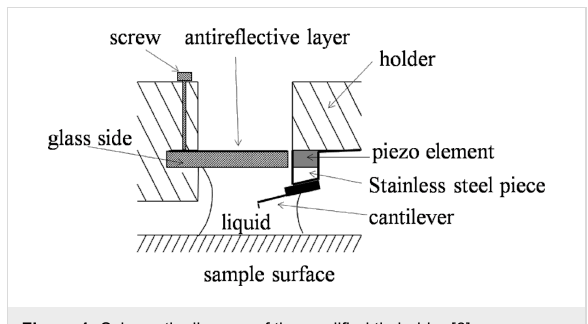
Figure 1: Schematic diagram of the modified tip holder [6].